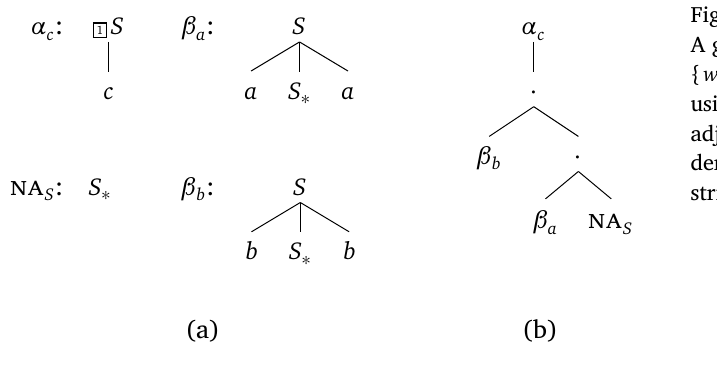
Figure 10: A grammar (a) for f wcw R j w 2 f a , b g (cid:3) g using general multiple adjunction, and (b) a derivation of the string abba